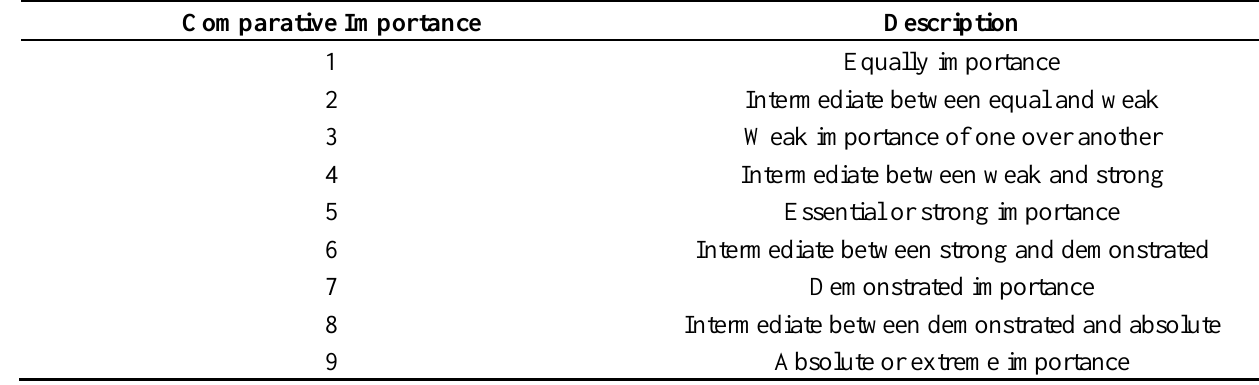
Table 6. Relative degree of importance for pairwise comparisons.